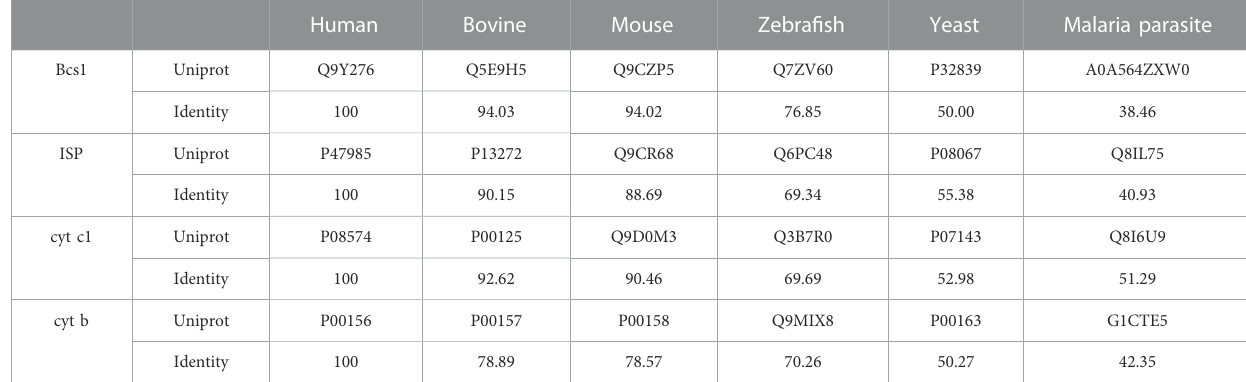
TABLE 1 Sequence conservation to human homologue. Human Bovine Mouse Zebra fi sh Yeast Malaria